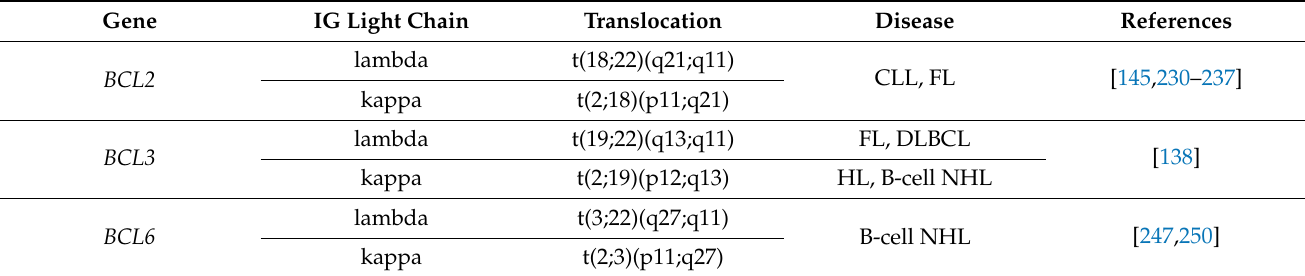
Table 3. Translocations involving immunoglobulin light chain loci in B-cell malignancies. Gene IG Light Chain